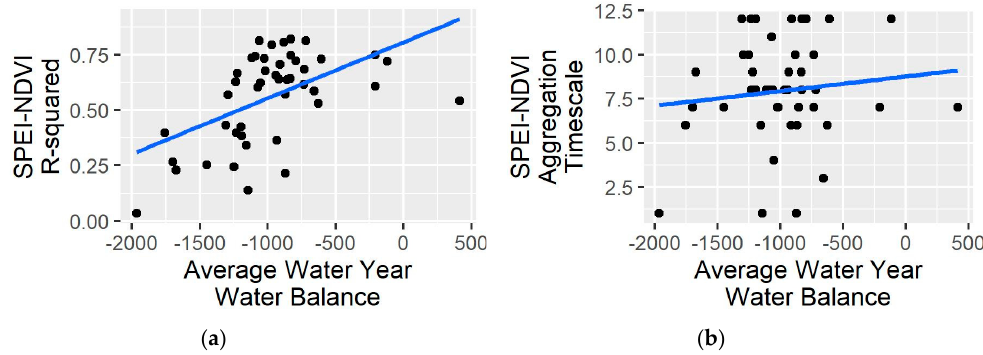
Figure 4. Relations between ecoregional long-term (1984–2018) average water year water balance (PPT-PET) and ( a ) the strength (indicated by R-squared) of the relationship between optimal Standardized Precipitation–Evapotranspiration Index (SPEI) timescale and late summer NDVI (as % difference from long term average) and ( b ) the optimal aggregation timescale at which the correlation between SPEI and NDVI is maximized. Table 2. Descriptive statistics of Sen’s slope distributions by vegetation type, hydrography, land ownership, and landform/climate. Red (blue) shading corresponds with negative (positive) central tendencies. Orange shading indicates magnitude of standard deviation.